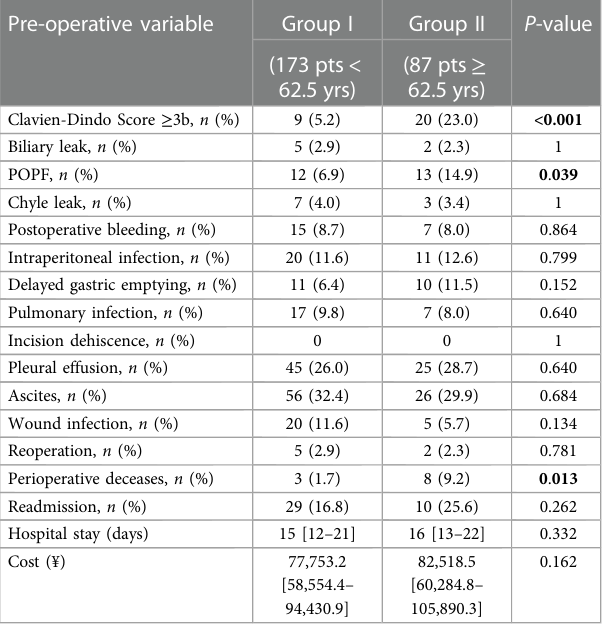
TABLE 3 Short-term outcomes of two groups who had undergone pancreaticoduodenectomy. Pre-operative variable